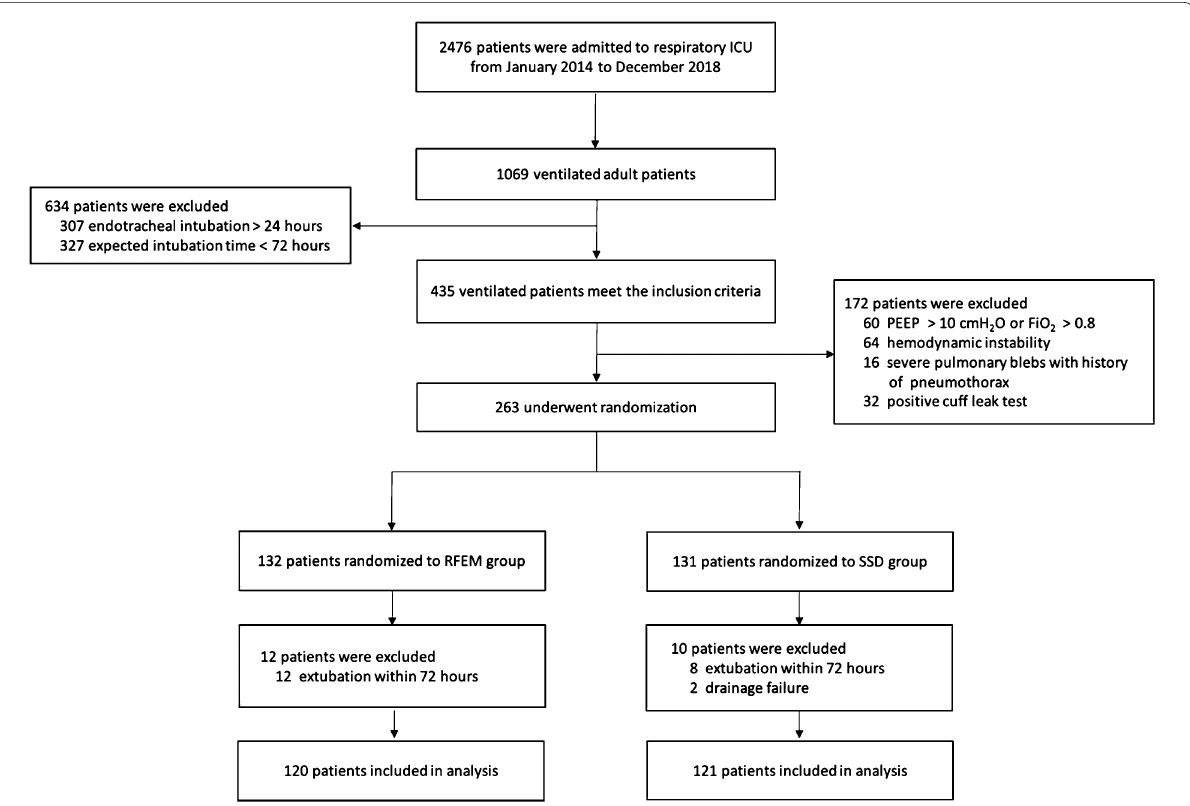
Fig. 1 Flowchart of patients admitted to the respiratory intensive care unit (RICU) between January 2014 and December 2018